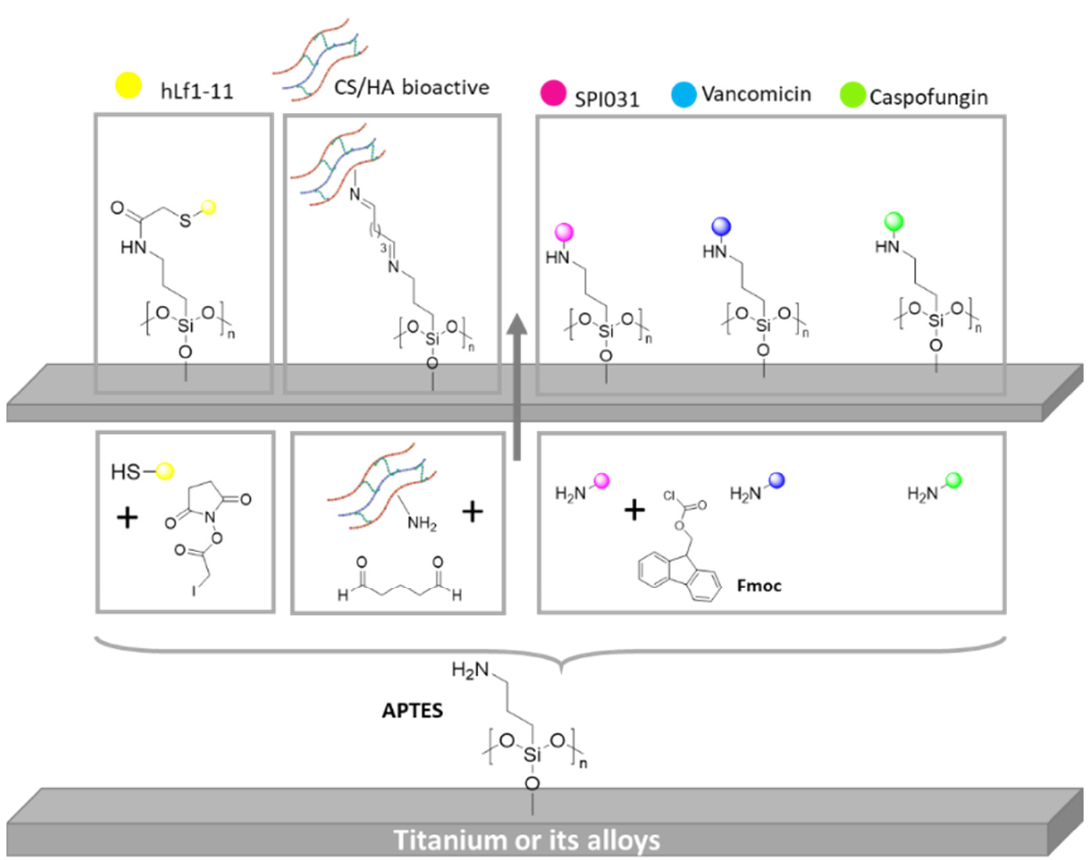
Figure 7. Schematic representation of different bioactive compound immobilization through si- lanization.